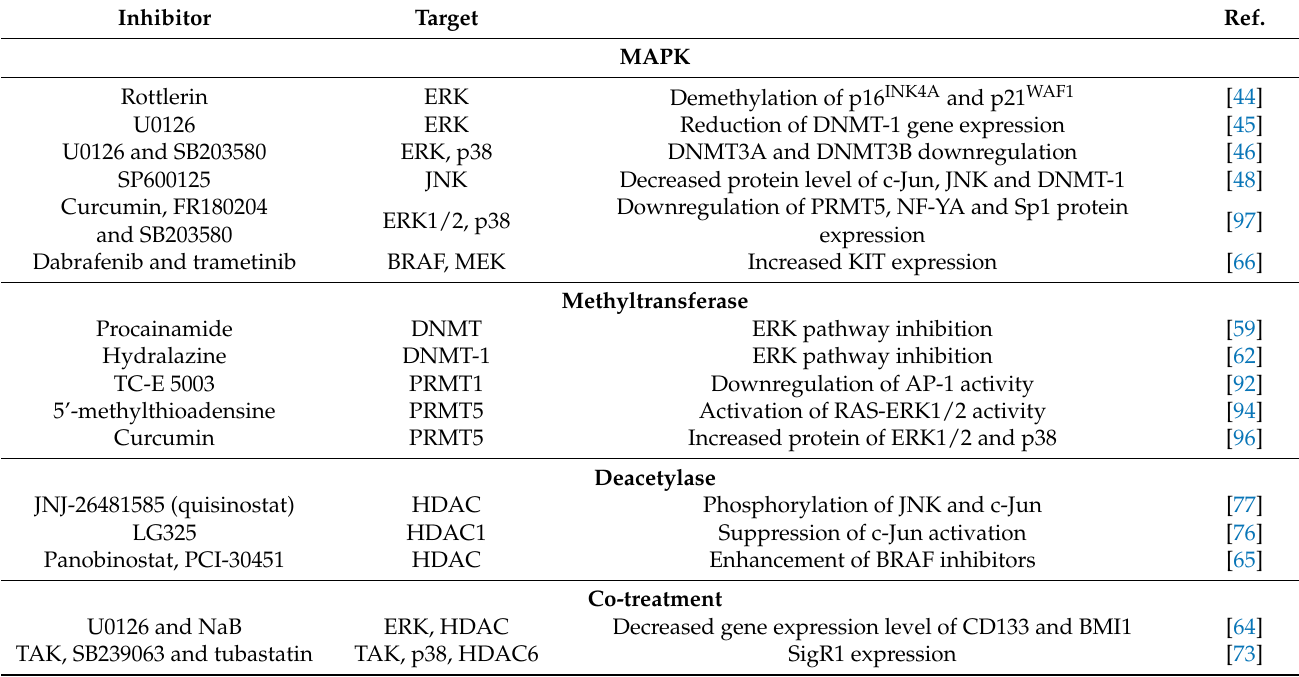
Table 3. Summary of compounds and inhibitors mentioned in this